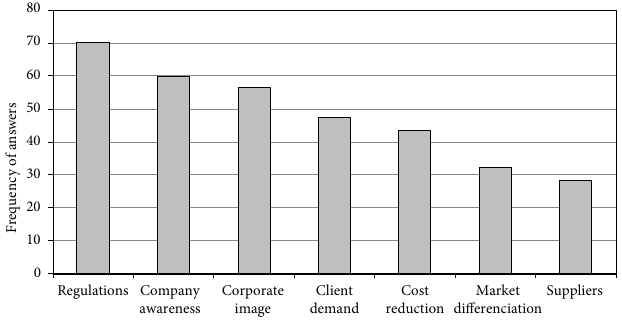
Fig. 3. Drivers which promote SC practices among Chilean Construction companies